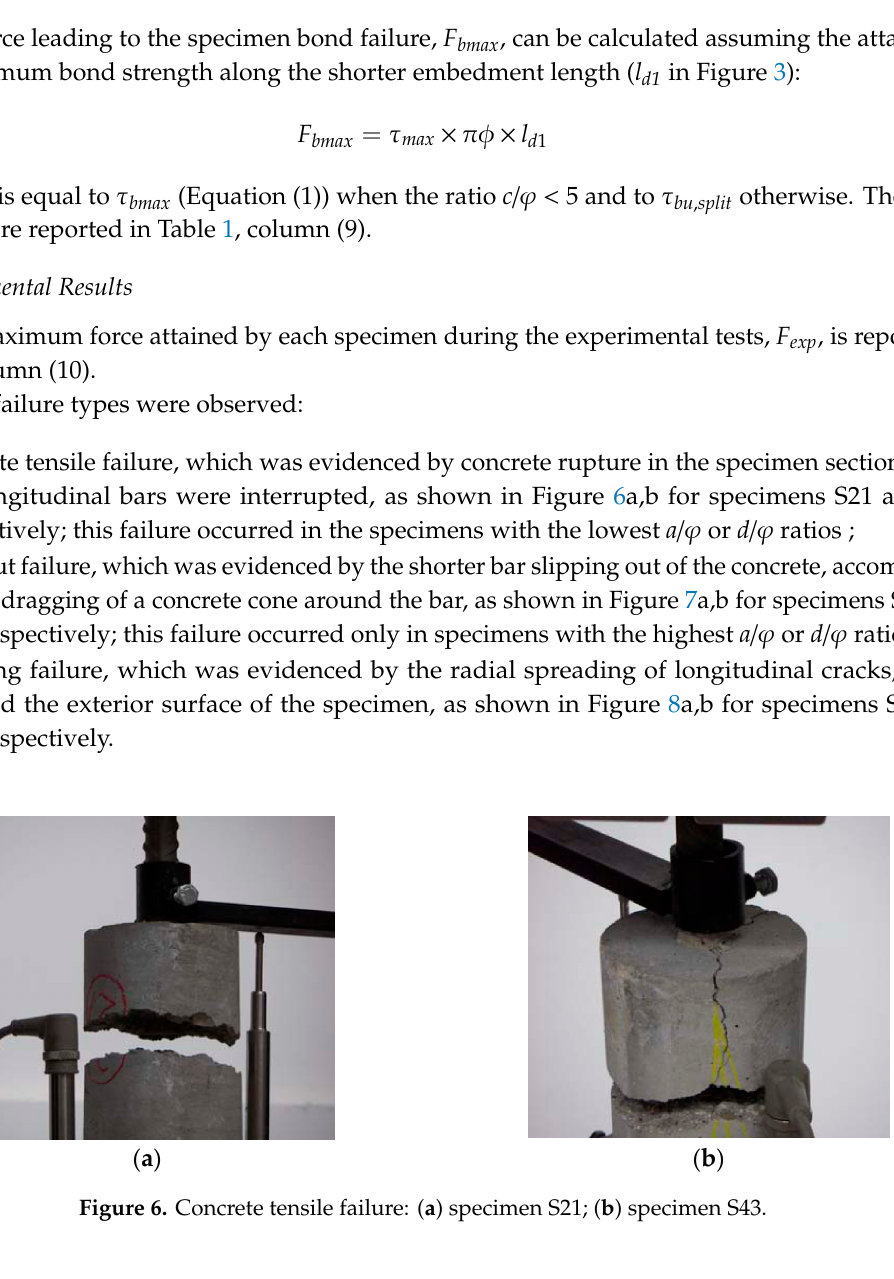
( a ) ( b ) Figure 7. Concrete tensile failure: ( a ) specimen S25; ( b ) specimen S53. ( a ) ( b ) Figure 8. Concrete tensile failure: ( a ) specimen S10; ( b ) specimen S52. ( a ) ( b ) Figure 9. Specimens exhibiting pull-out failure accompanied by splitting failure: ( a ) specimen S7; ( b ) specimen S42.